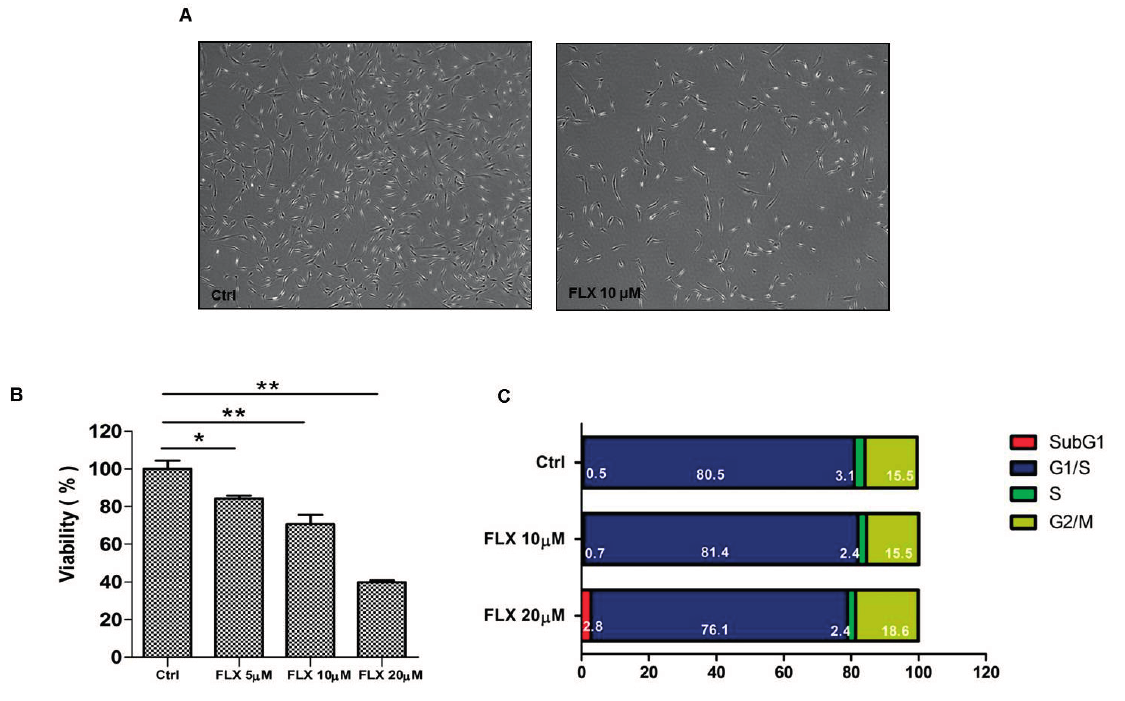
Figure 1. Fluoxetine decreased the proliferation of ASCs in the CCK-8 assay. ( A